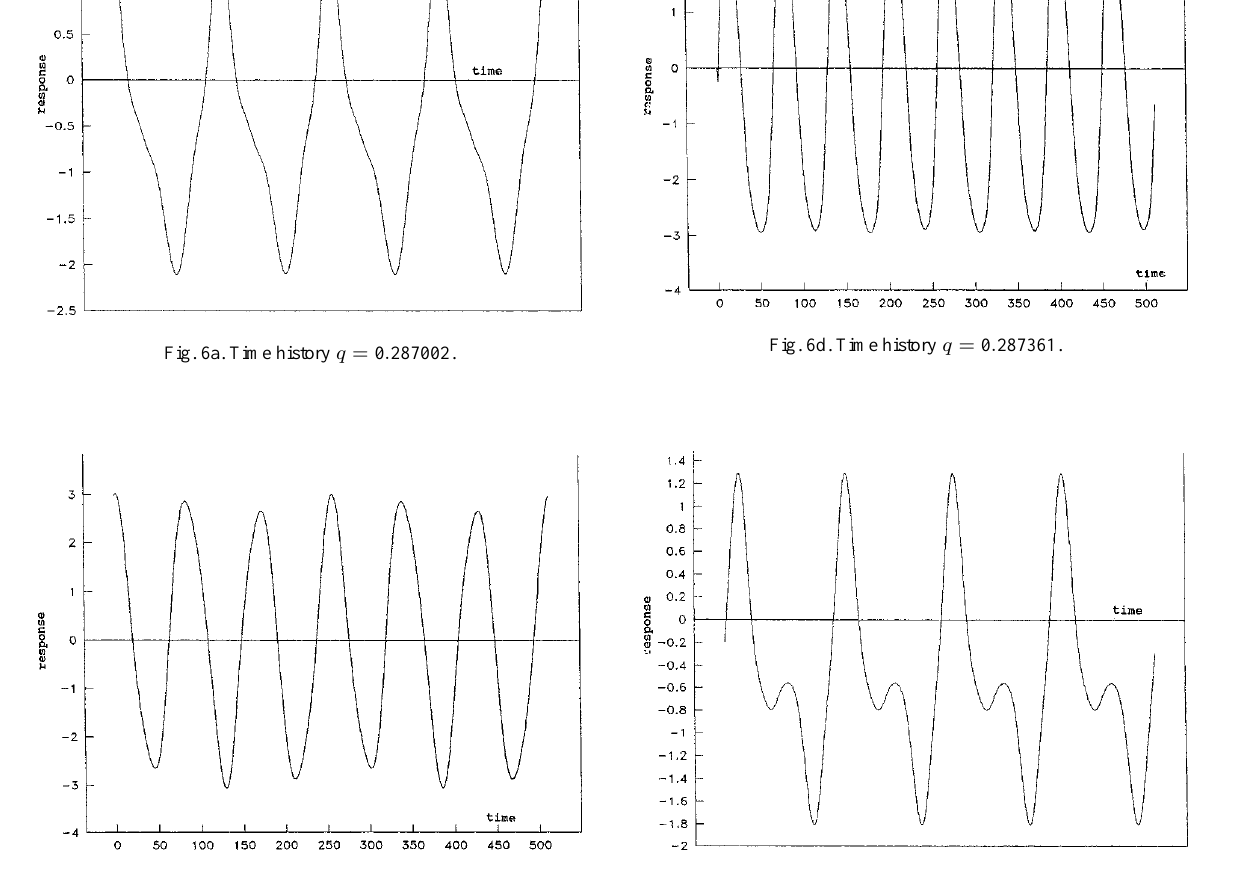
Fig. 6e. Time history q = 0 :